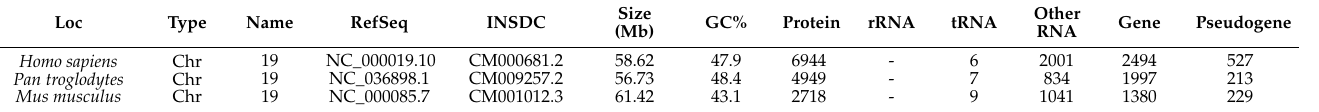
Table 1. Case study genome information for reference and representative genomes. Homo sapiens assembly GRCh38.p13, Pan troglodytes assembly Clint_PTRv2 and Mus musculus assembly GRCm39. Download sequences and annotation from GenBank